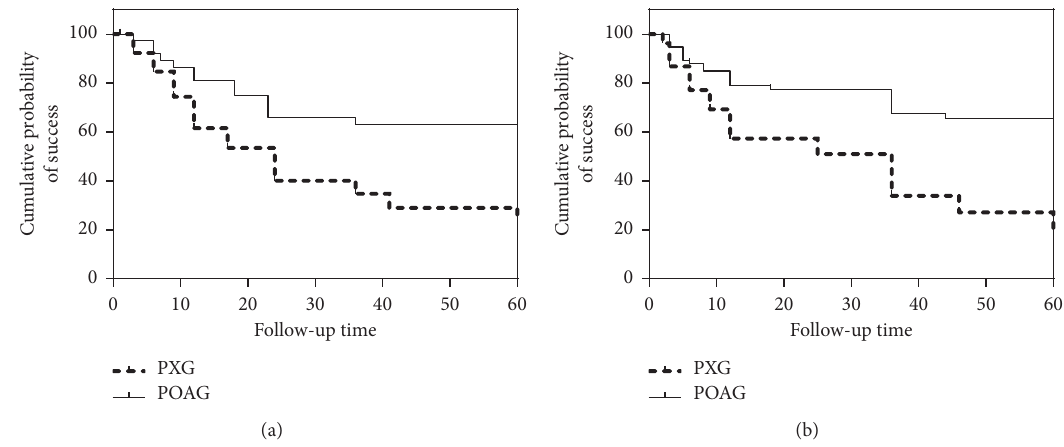
Figure 2: Kaplan–Meier survival analysis of complete (a) and qualified (b) success of trabeculectomy in patients according to criterion B in the PXG and POAG groups. Complete and qualified success rates were significantly different in the PXG and POAG groups ( P � 0 . 000, P � 0 . 020, Mantel–Cox log-rank test, and criterion B).